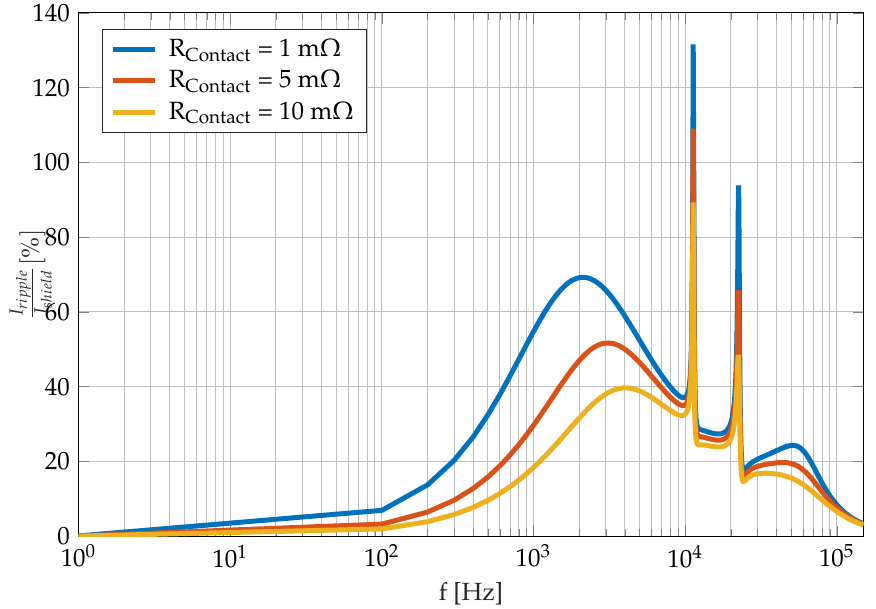
Figure 7. Simulated proportion of shield and inverter currents in the function of frequency with three different contact resistance values. With low shield resistance at the resonance frequency of the HV system the individual shield can amplify the inverter ripple